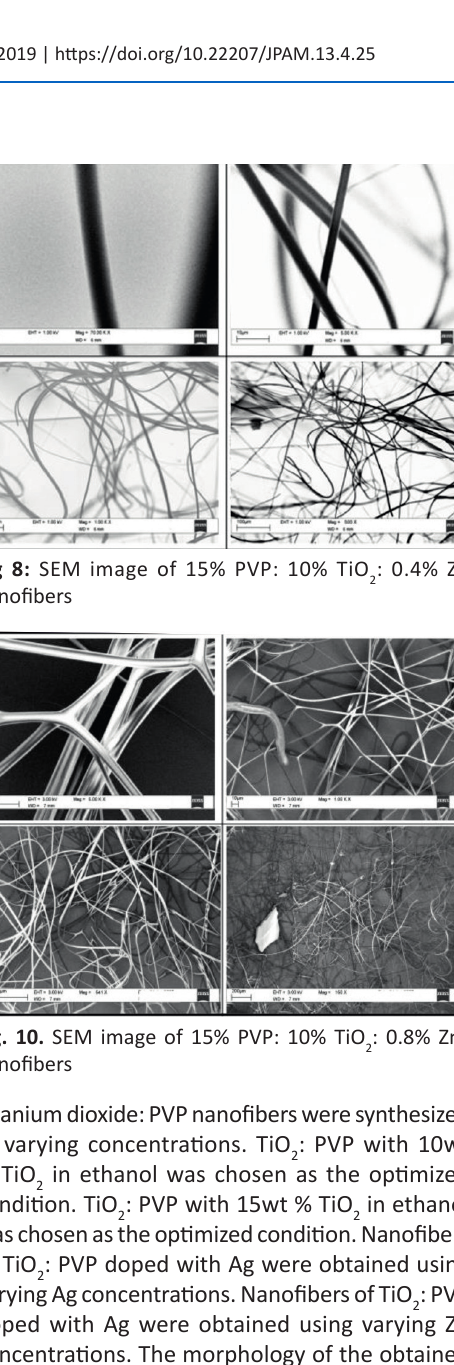
Fig. 9. SEM image of 15% PVP: 10% TiO nanofibers